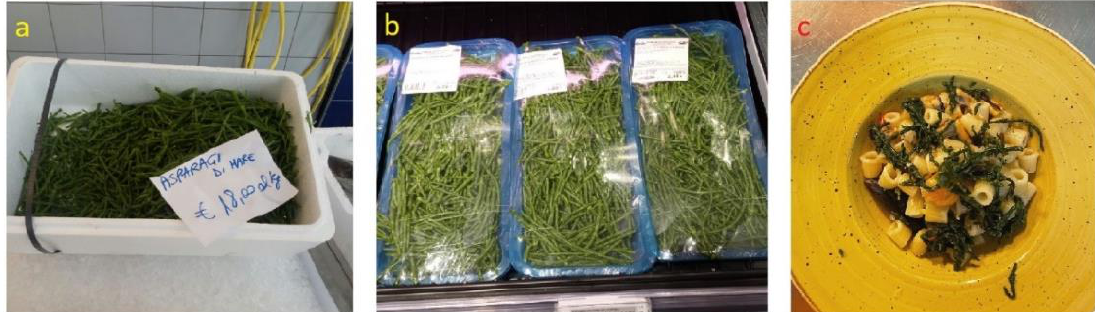
Figure 4. Distribution, across the Apulia region, of the food use of halophytes and halotolerant spe- cies treated in this contribution, according to our field observations and literature data.